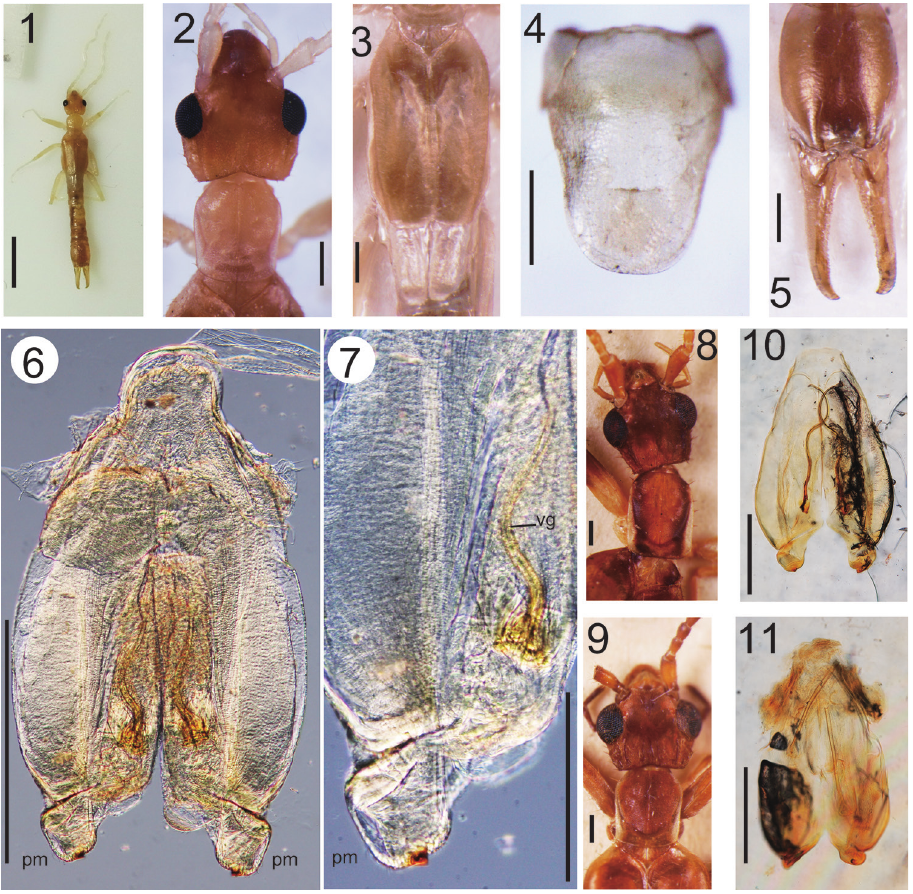
Figures 1–11. 1–7 Cylindrogaster cavernicola Kamimura, sp. n. (male, holotype): habitus ( 1 ), head and thorax ( 2 ), tegmina and wings ( 3 ), penultimate sternite ( 4 ), ultimate tergite and forceps ( 5 ), and genita- lia ( 6, 7 ) 8, 10 Cylindrogaster thoracicus (MM 3637; collected from Itatiaia, Brazil; det. W. D. Hincks): head and thorax ( 8 ), and genitalia ( 10 ) 9, 11 Cylindrogaster gracilis : head and thorax ( 9 : MM 3677; collected from Itatiaia, Brazil; det. W. D. Hincks), and genitalia ( 11 : MM 3565; collected from Minas Gerais, Brazil; det. W. D. Hincks). Scale bars 3 mm for Fig. 1 ; 0.5 mm for Figs 2–6, 8–11 ; 200 μm for Fig. 7 . a more or less semicircular lobe. Ultimate (= 10 th ) tergite (Fig. 5) moderately